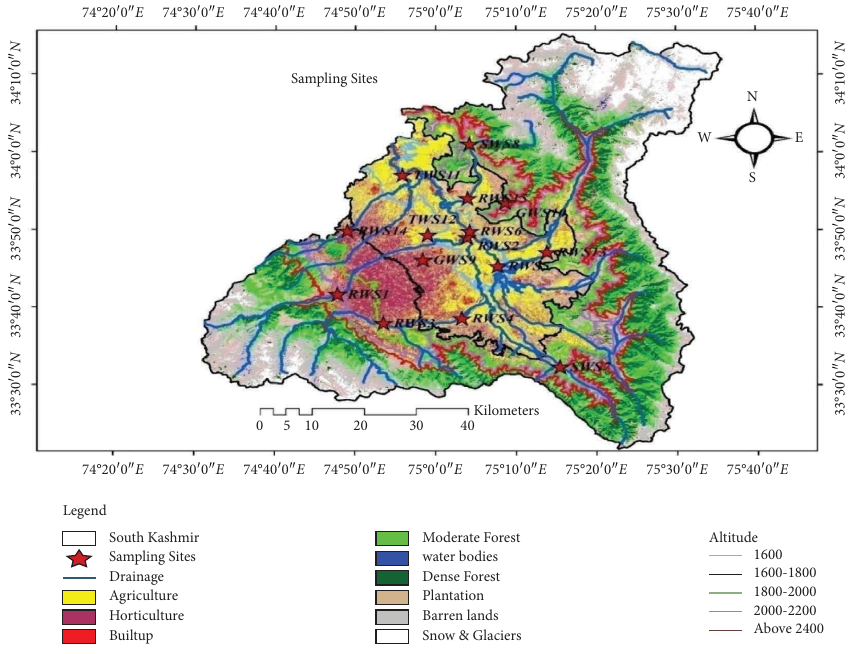
Figure 1: Study area & sampling site map; source SOI toposheets 1971 & satellite data 2017.